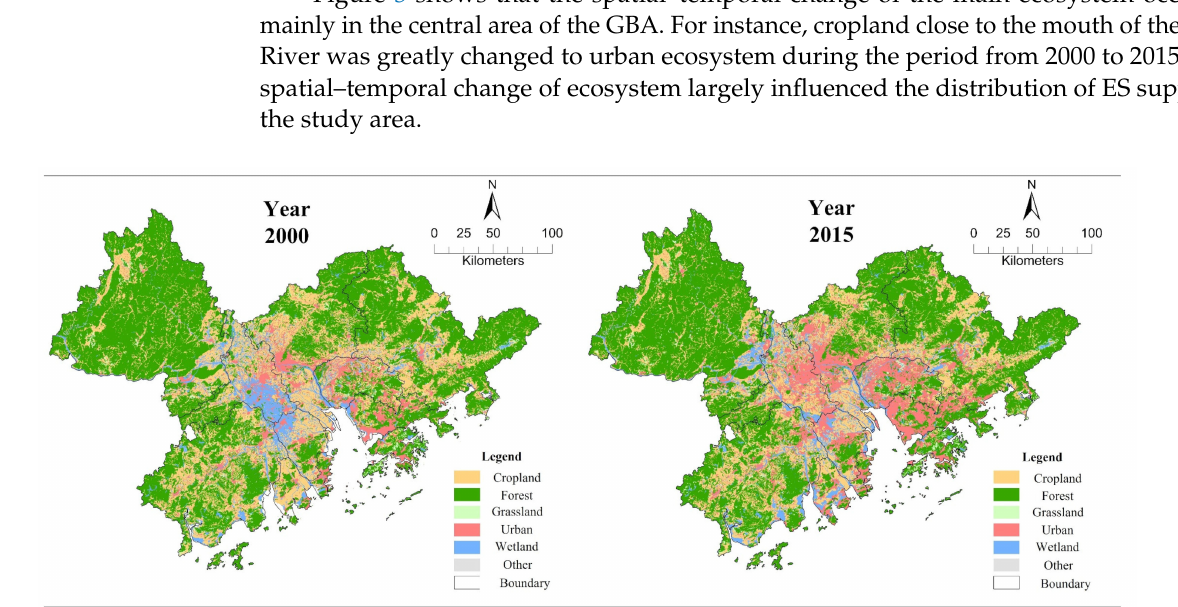
Figure 3. Spatiotemporal pattern of main ecosystem types in the Greater Bay